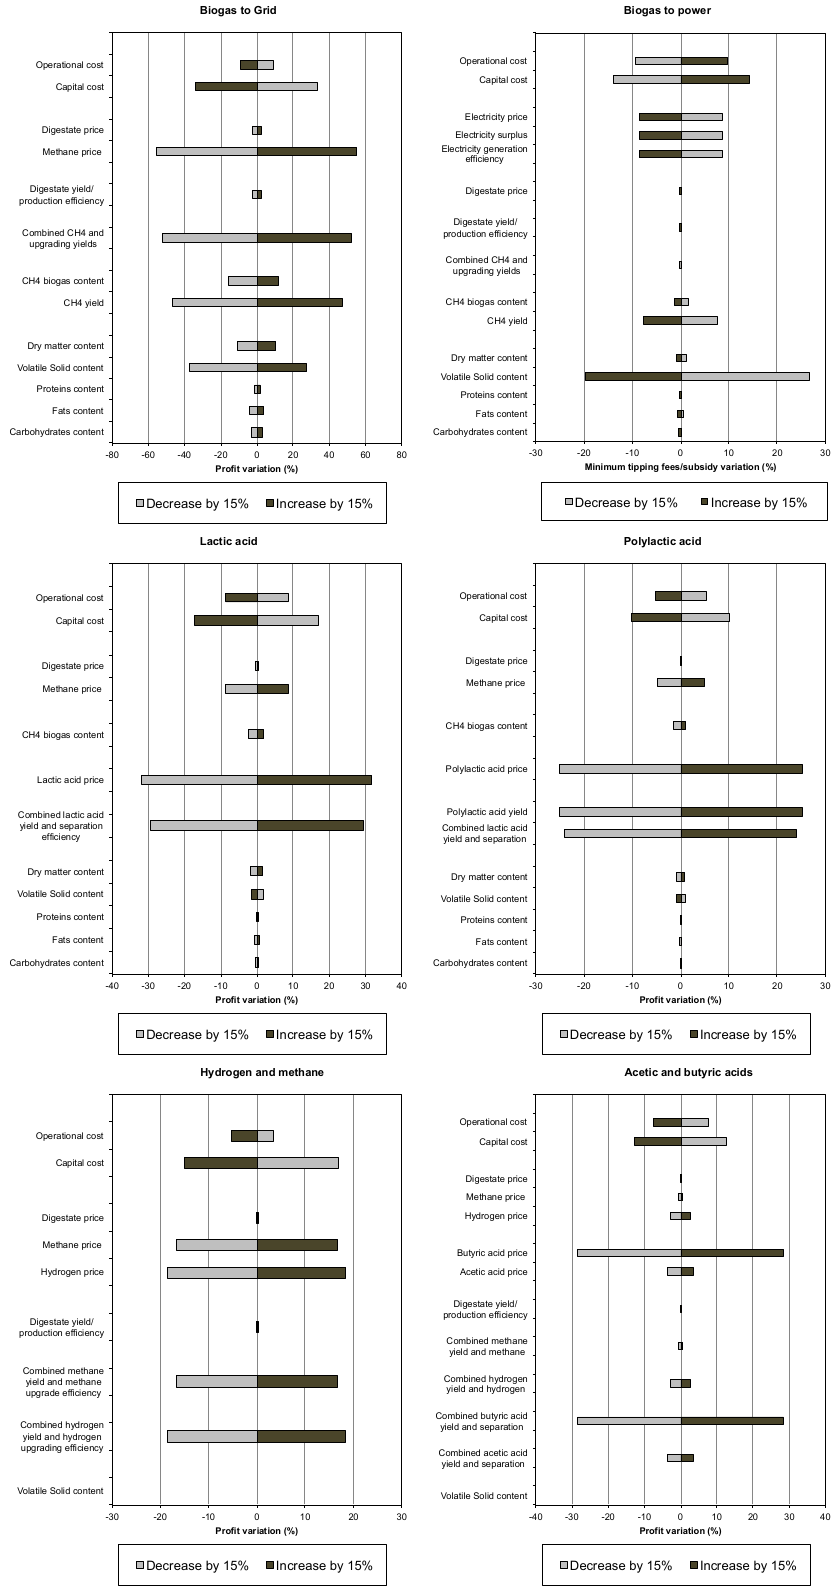
Figure 4. Economic sensitivity analysis results for the different assessed scenarios. All the scenarios where evaluated in a time frame of 20 years, with an annual interest of 5%. Costs include the capital cost, converted to annual, plus the annual operational cost.